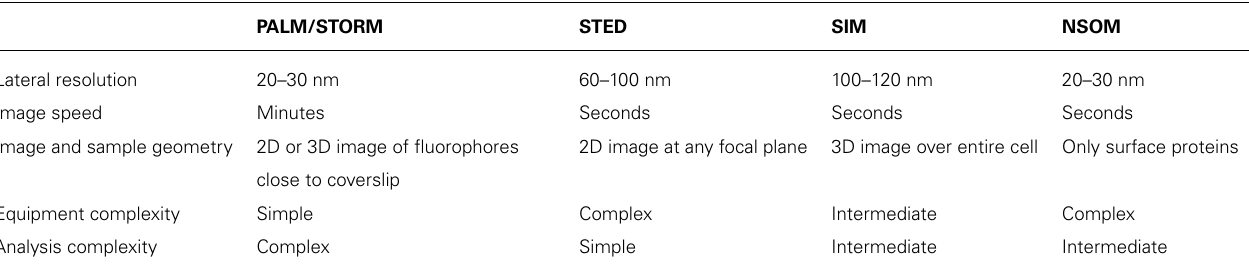
Table 1 | Summary of super-resolution imaging techniques to probe membrane organization below the diffraction